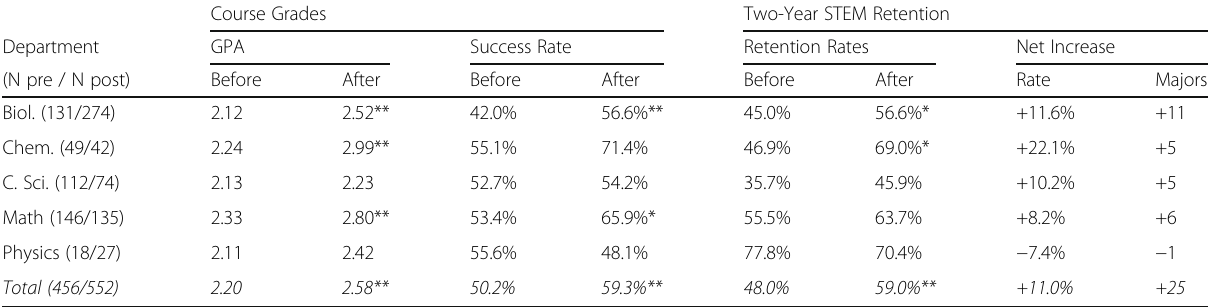
Table 4 The GPA and course success rates (defined as a grade of B- or better) for majors in the supported gateway course. Also presented are two year retention rates within STEM, the percentage point increase in the retention rate, and the number additional number of majors retained per year. Significant differences are marked with * ( p < 0.05) and ** ( p <